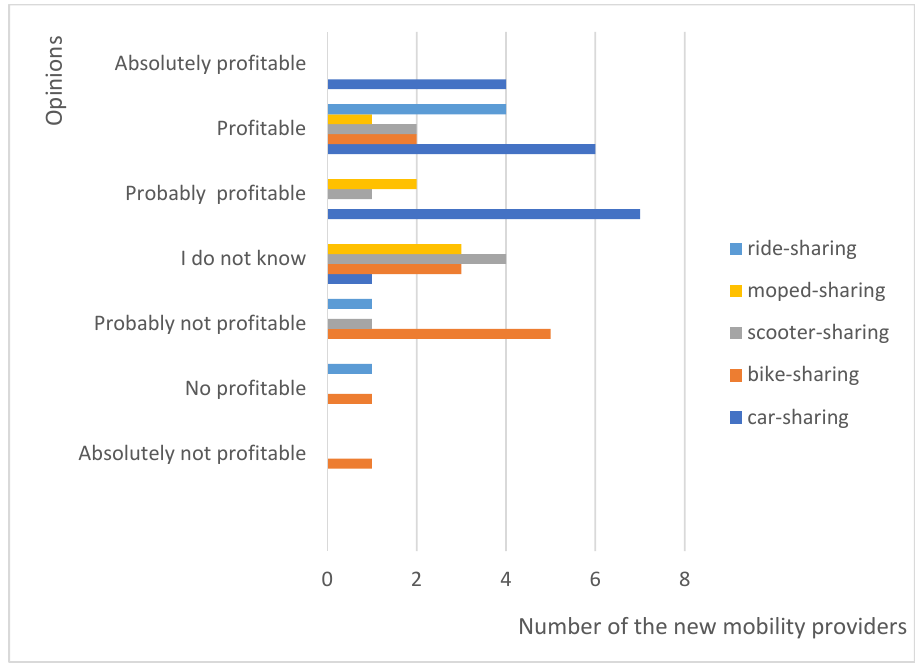
Figure 8. Innovation level of the implemented practices from the new mobility providers’ point of view—detailed results broken down into new mobility sectors.